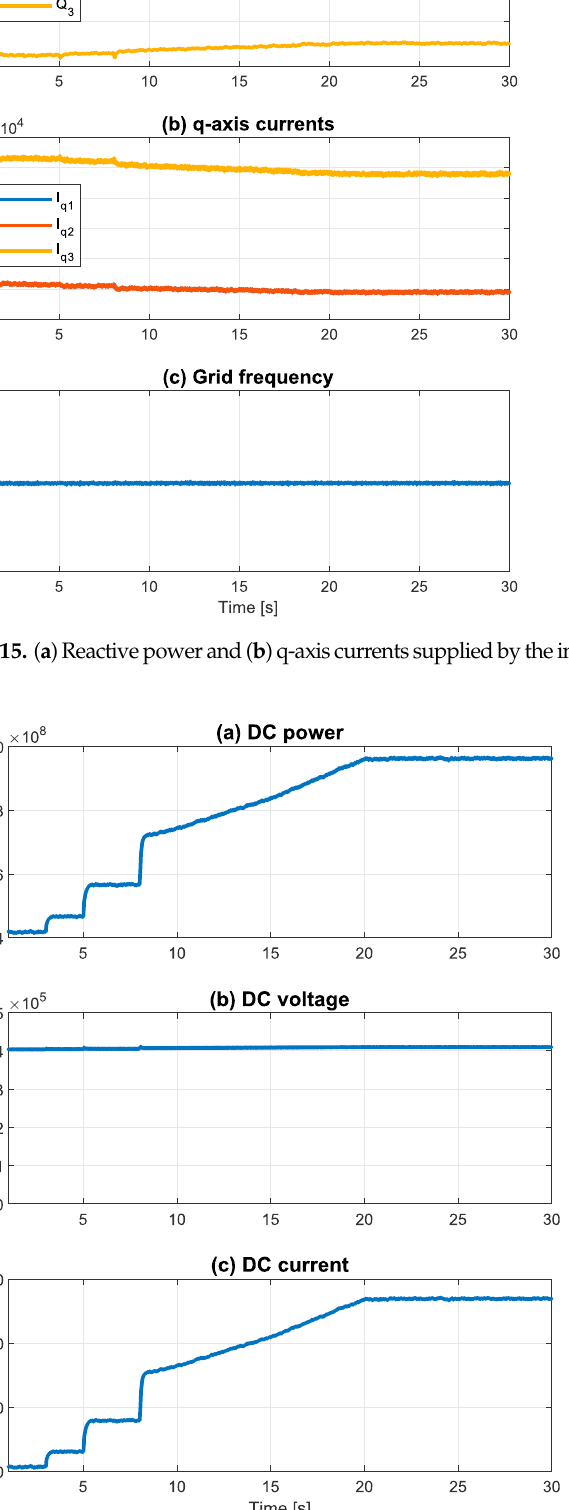
Figure 16. DC-side variables: ( a ) power, ( b ) voltage, and ( c ) current.